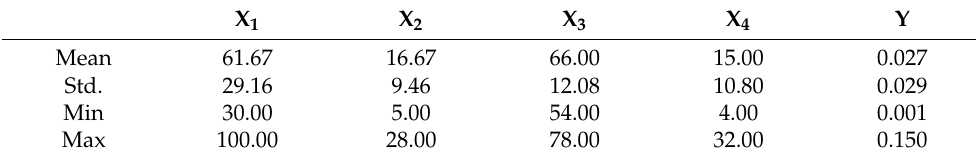
Table 3. Statistics information for the dependent variable and independent variables.